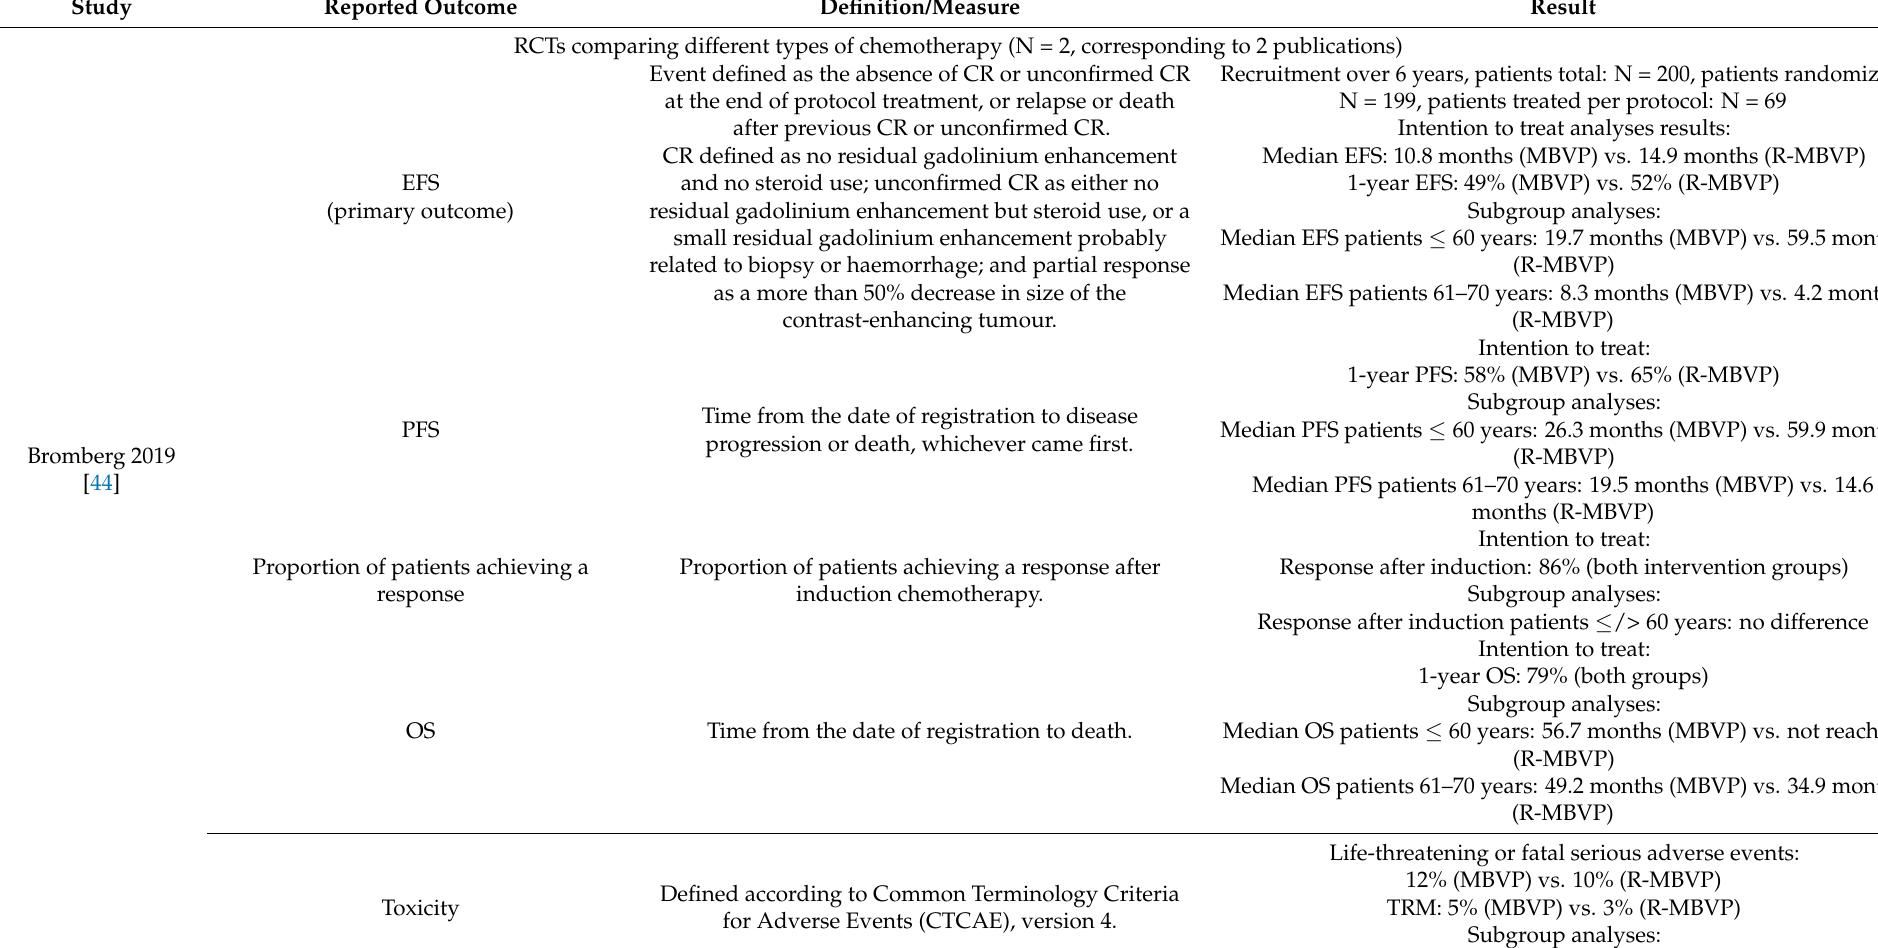
Table 2. Outcomes considered and design aspects in the randomized trials including protocol. Study Reported Outcome Definition/Measure Result RCTs comparing different types of chemotherapy (N = 2, corresponding to 2 publications) Event defined as the absence of CR or unconfirmed CR at the end of protocol treatment, or relapse or death after previous CR or unconfirmed CR. CR defined as no residual gadolinium enhancement and no steroid use; unconfirmed CR as either no residual gadolinium enhancement but steroid use, or a small residual gadolinium enhancement probably related to biopsy or haemorrhage; and partial response as a more than 50% decrease in size of the contrast-enhancing